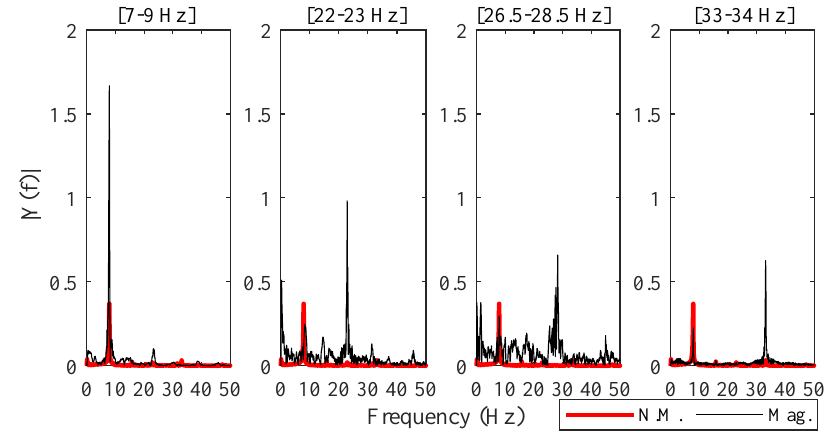
Figure 9. Fourier spectra comparison of tracked motion obtained through non-magnified (N.M.) and magnified